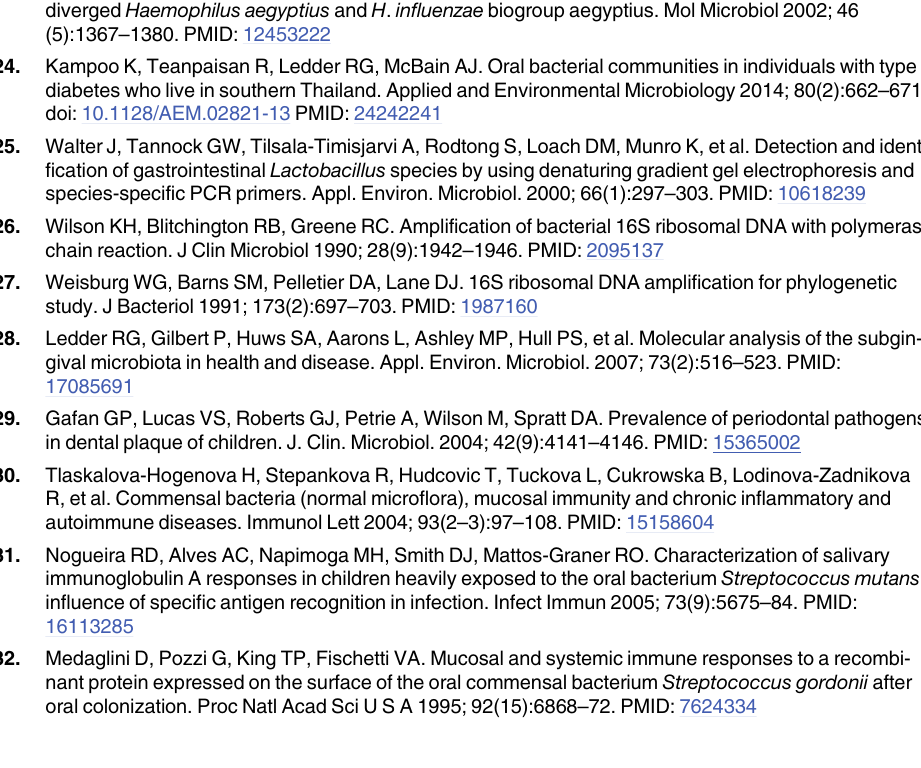
PLOS ONE | DOI:10.1371/journal.pone.0158288 August 2,